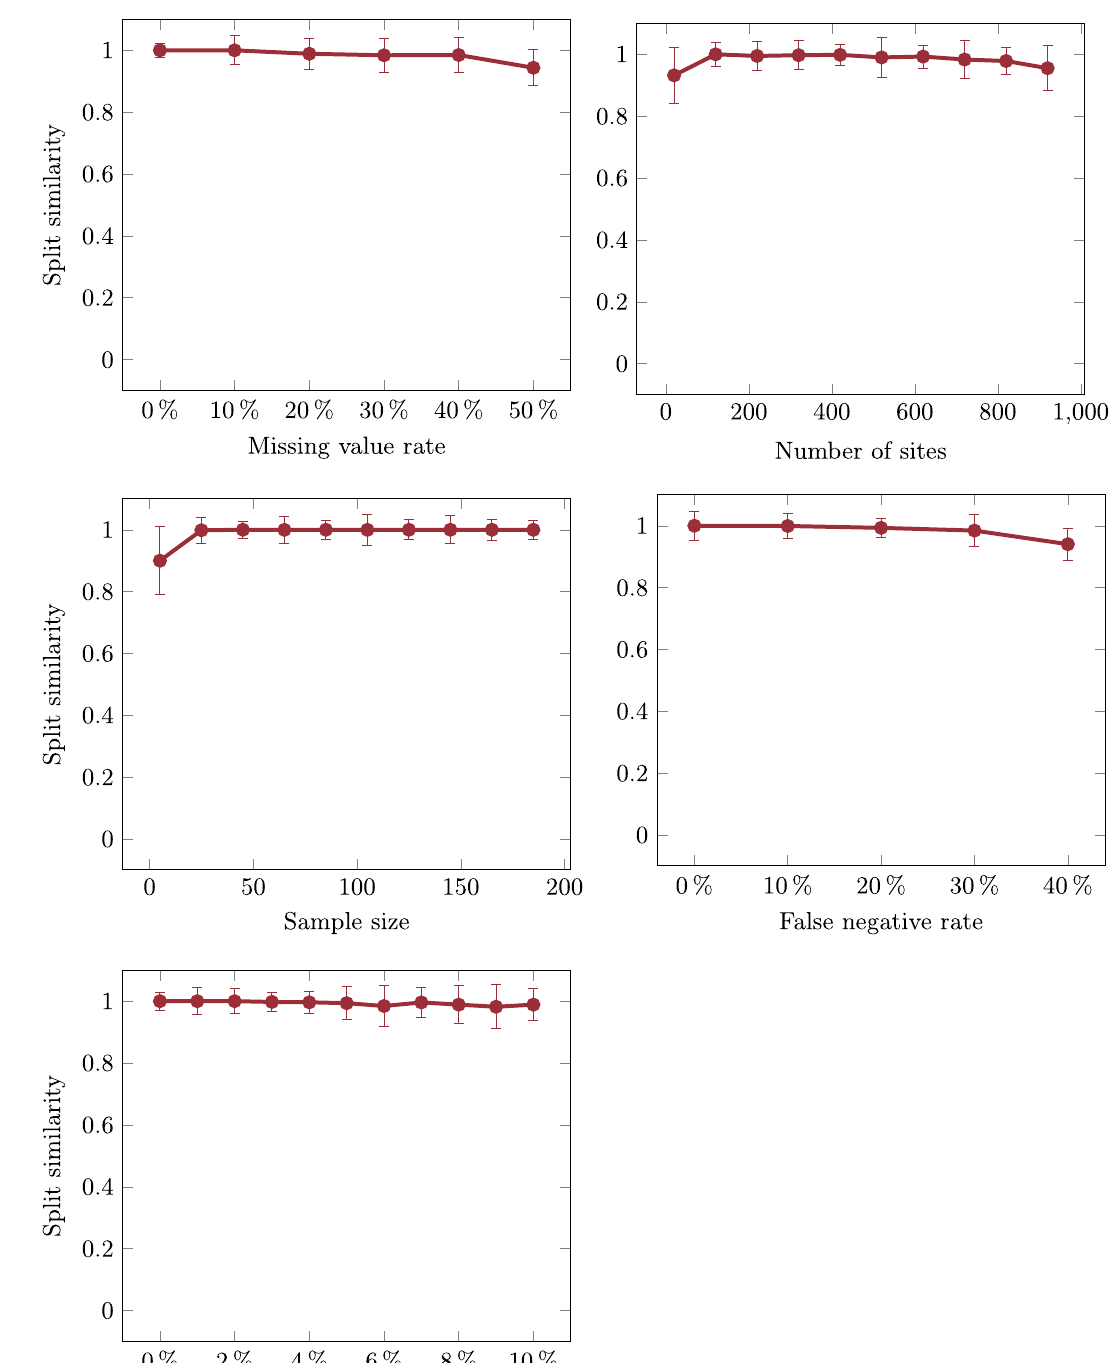
Fig 4. Robustness of Scelestial to variation in the properties of ground truth lineage trees in terms of topological similarity between the inferred and ground truth trees.